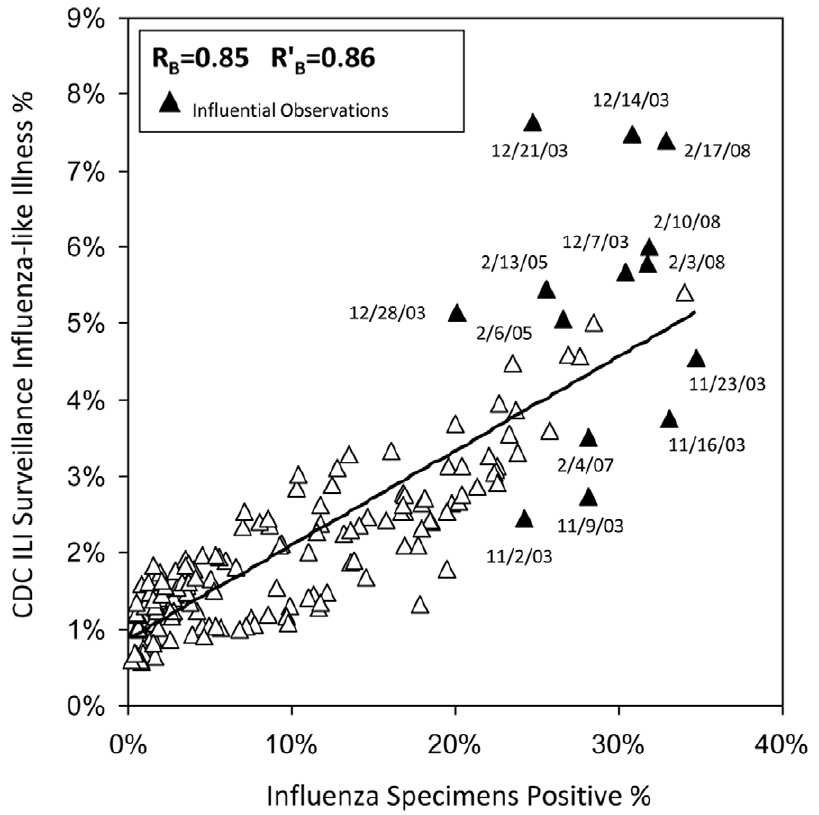
Figure 3. Scatter Plot CDC ILI Surveillance and CDC Influenza Laboratory Surveillance; September 28, 2003 through May 17, 2008. 1. Data Sources: a. Outpatient Influenza-like Illness Surveillance Network; (http://www.cdc.gov/flu/weekly/fluactivity.htm); and b. US Influenza Virologic Surveillance System (http://www.cdc.gov/flu/weekly/fluactivity.htm). 2. For CDC influenza surveillance, Influenza-like Illness (ILI) is defined as a fever $ 37.8˚C and a cough and/or a sore throat without known etiology [22]. 3. There are 166 total observations in each panel. Influential observations were defined by DFBETA statistic greater than the absolute value of 2 divided by the square root of the total number of observations in a simple linear regression model [17]. 4. R B represents Pearson’s correlation coefficients calculated from comparisons of Outpatient Influenza-like Illness Surveillance with US Influenza Virologic Surveillance. 5. R’ B represents the calculated Pearson’s correlation coefficients after exclusion of all influential observations. 6. Because CDC surveillance is intensified from calendar week 40 through calendar week 20 of the subsequent year, we restricted our correlation analyses to this time period.